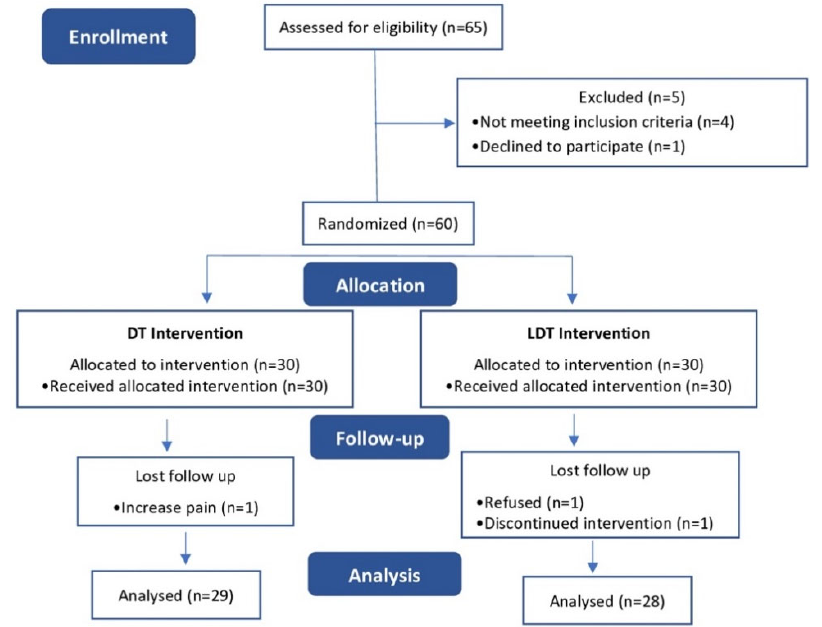
Figure 1. CONSORT flow chart.